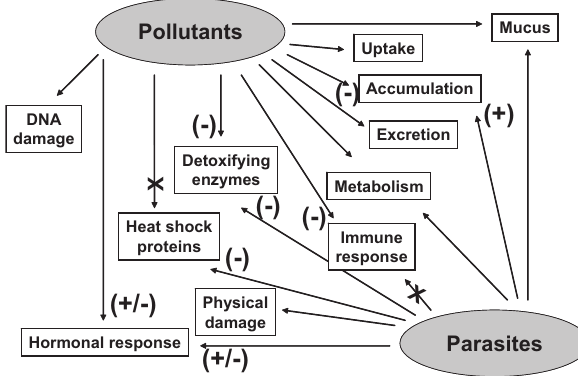
Fig. 2. – Interaction of combined effects of parasites and